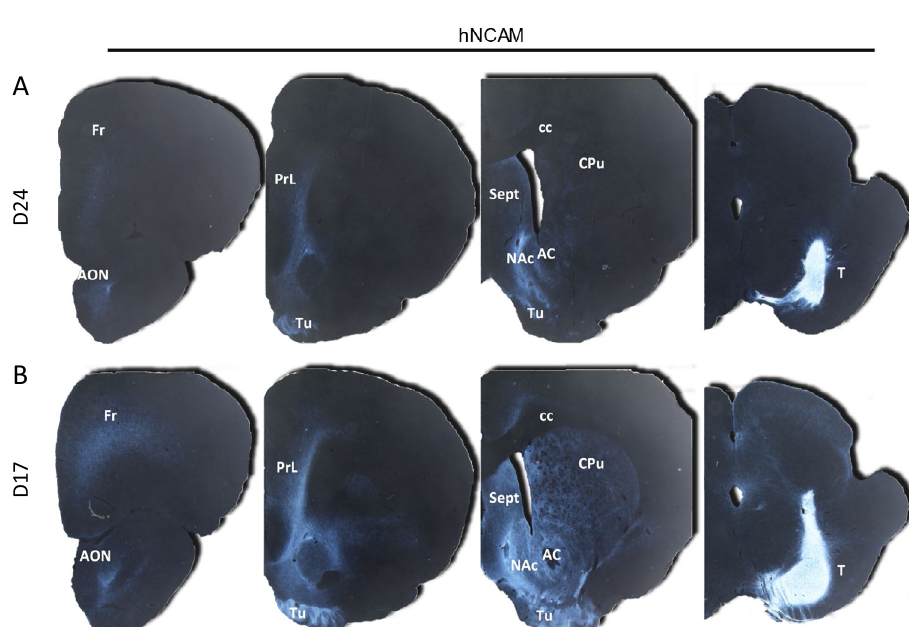
Fig. 5 Long-range innervation of grafted cells transplanted in substantia nigra. Representative computer-inverted micrographs of hNCAM immunoreactivity in coronal sections spanning from the forebrain to the site of transplant in the substantia nigra. DAB-processed images were inverted and adjusted to show extent of innervation; all enhancements were applied to each sample in an identical fashion. AC anterior commissure, AON anterior olfactory nucleus, cc corpus callosum, CPu caudate/putamen, Fr frontal cortex, NAc nucleus accumbens, PrL prelimbic area, Sept septum, T transplant, Tu olfactory